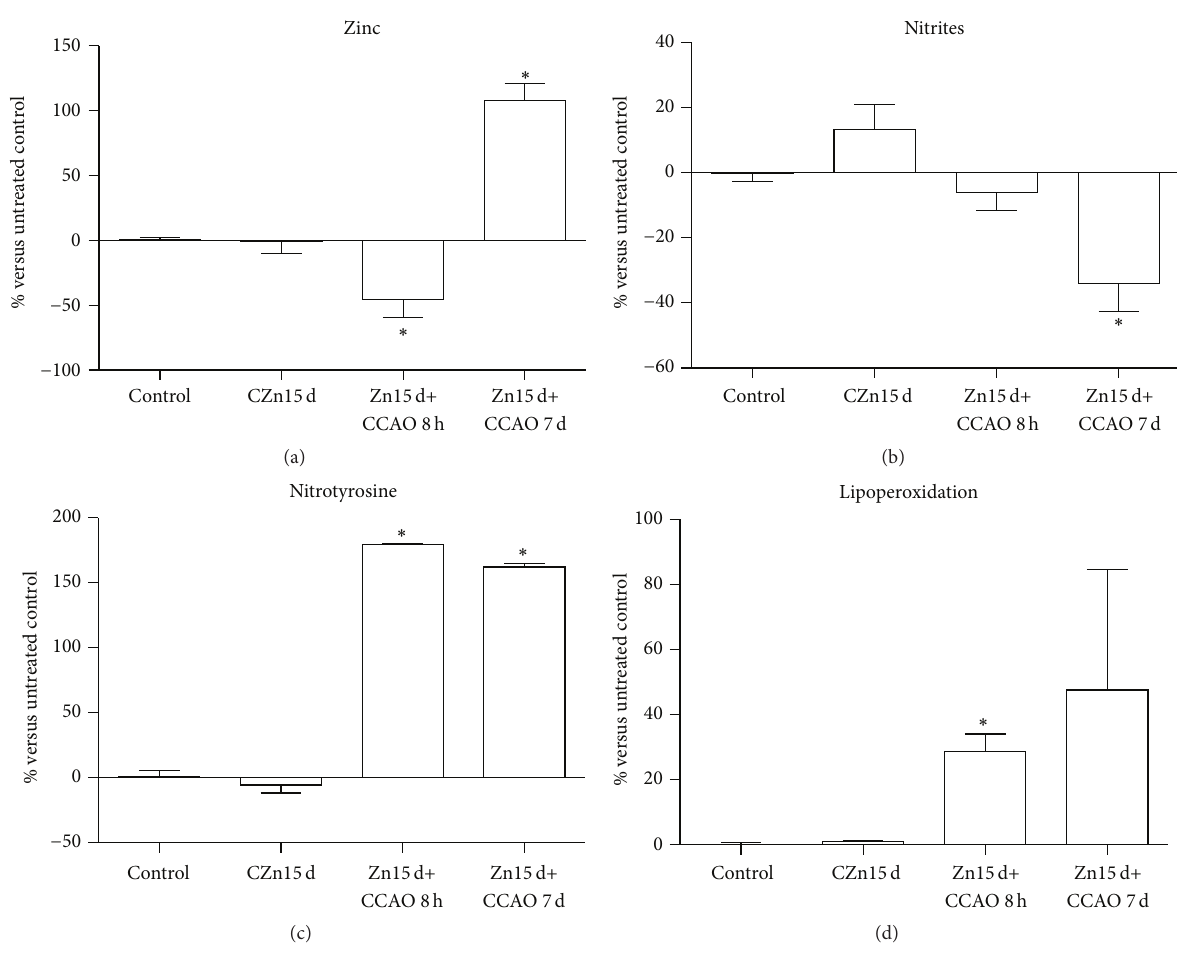
Figure 5: Effect of the chronic prophylactic administration of zinc on levels of zinc and stress nitrosative markers. CZn15d, rats with chronic administration of zinc; Zn15d+CCAO 8h, rats with chronic administration of zinc before CCAO and evaluations at 8 h after reperfusion; Zn15d+CCAO 7 d, rats with chronic administration of zinc before CCAO and evaluations at 7 days after reperfusion. Values are represented as the percentage with respect to untreated control. Each value represents the mean ± SEM of 5 independent experiments made in triplicate. ∗ Significantly different from untreated rats (Student’s 𝑡 -test). The significance was established at 𝑃 < 0.05